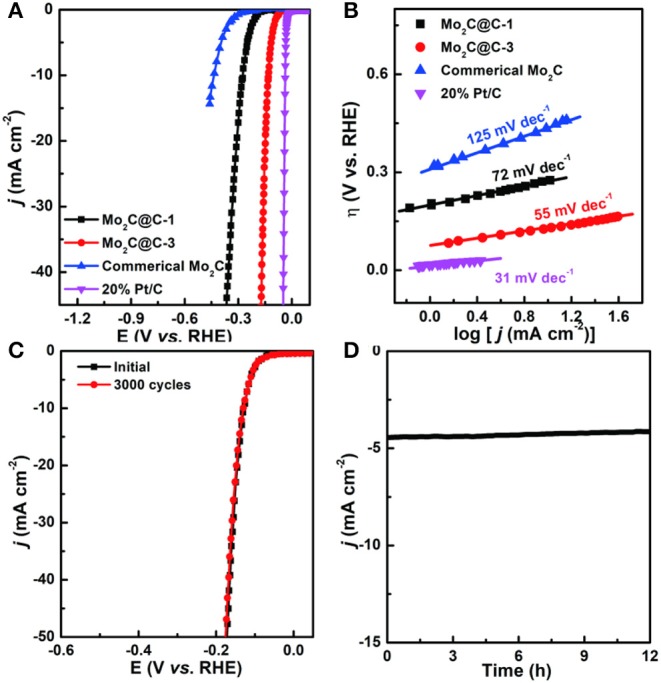
(A) LSV curves and (B) Tafel plots of Mo2C@C-1, Mo2C@C-3, 20% Pt/C, and commercial Mo2C in 0.5 M H2SO4 solution. (C) Cycling stability of Mo2C@C-3 before and after 3,000 cycles and (D) Galvanostatic data of the Mo2C@C-3 for 12 h in 0.5 M H2SO4 solution.